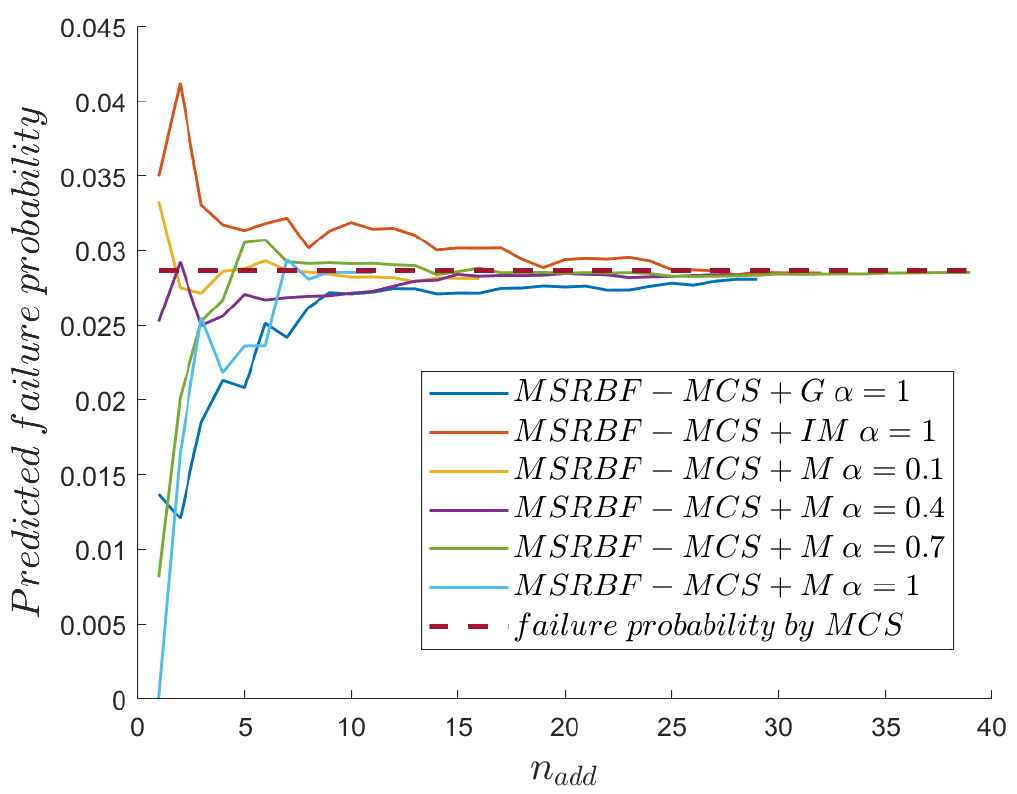
Figure 8. Convergence curves for different α in example